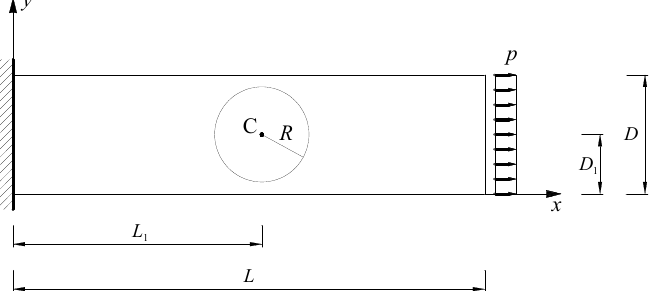
Figure 26. Geometry and loading condition of the elastic cantilever beam with a round inclusion [5]. Table 1. Geometric parameters used to model the beam of Figure 26 [5].